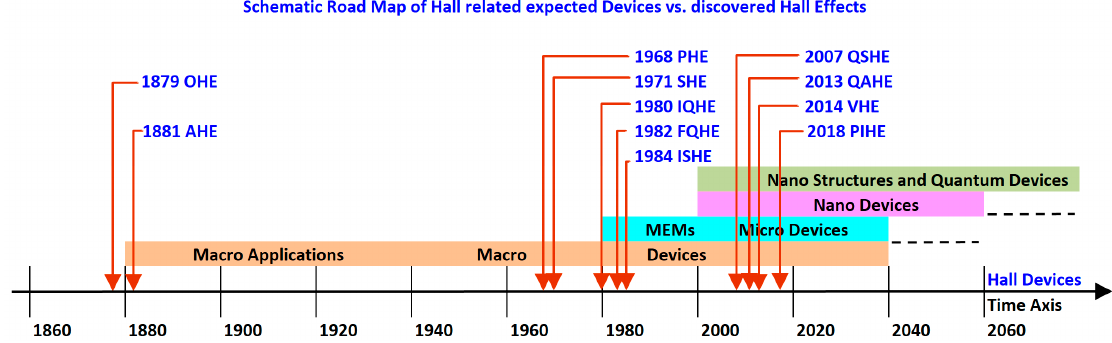
Figure 2. Enhanced schematic time line of the main Hall related observed Effects vs. the integrated devices.